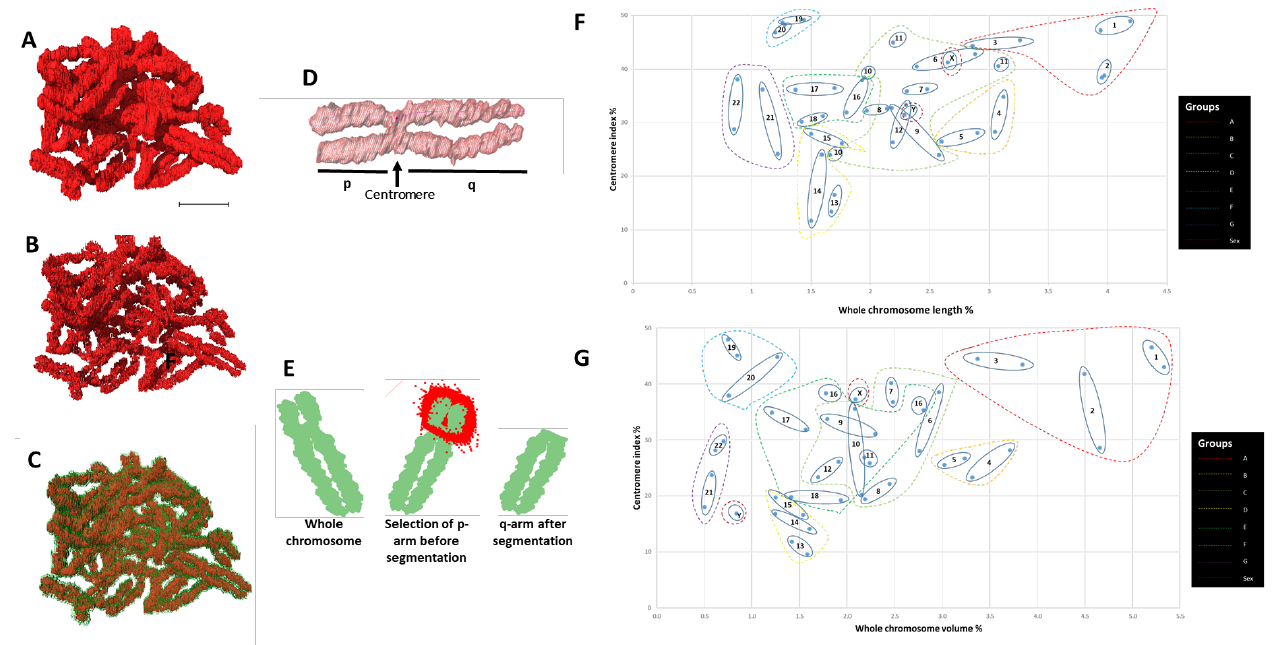
Figure 2. Identification of chromosomes. ( A ) 46 chromosomes after medium-segmentation. ( B ) 46 chromosomes after narrow-segmentation. ( C ) 46 chromosomes after medium (outer green color) and narrow (inner red color) segmentation from ( A ) and ( B ) respectively. ( D ) Length measurement of p and q arms of single chromosome. ( E ) Volume measurement of p and q arms of single chromosome. ( F ) Scatter diagram of eight groups (A to G and sex) labelled according to their assigned chromosome number. ( G ) Scatter diagram of centromere index against volume for all 46 individual chromosomes that are clustered after narrow-segmentation. Scale bar—2 µm.